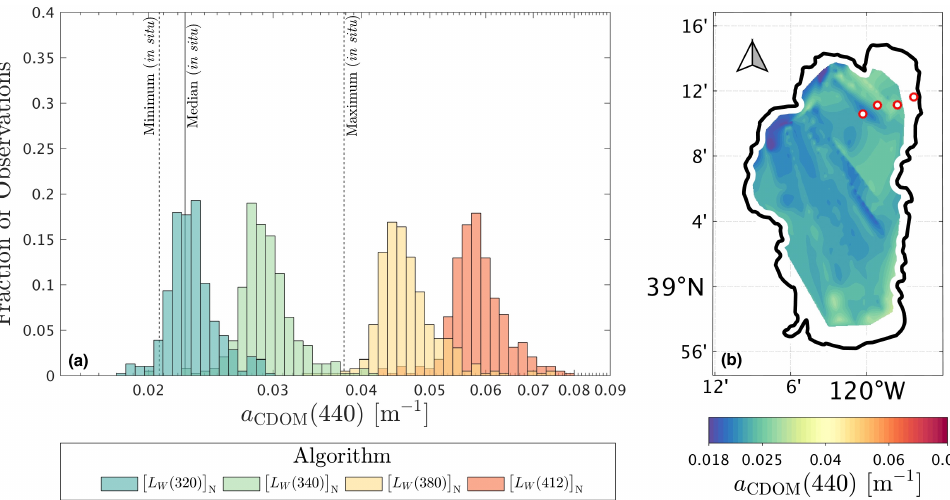
L W ( λ ) Figure 5. The one-band algorithms to derive a CDOM ( 440 ) at LT: ( a ) The distribution N of remotely estimated a CDOM ( 440 ) results using the color-coded algorithms (none of which are (cid:2) (cid:3) significantly biased across the global dataset) with respect to the in situ a CDOM ( 440 ) values indicated by labeled dashed and solid lines (left); and ( b ) the spatial interpolation of the applied to the airborne observations, with the in situ sampling sites indicated as red circles